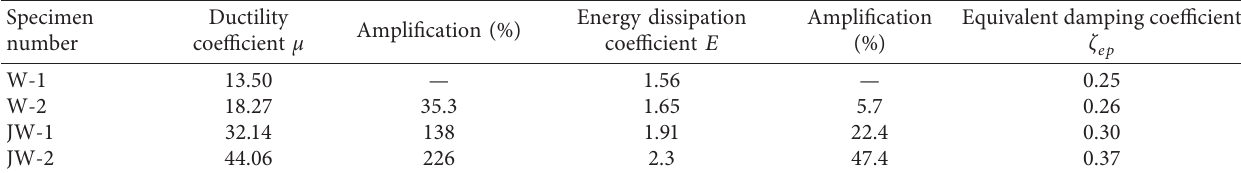
Figure 13: Calculation of energy dissipation coefficient. Table 4: Characteristic parameters of